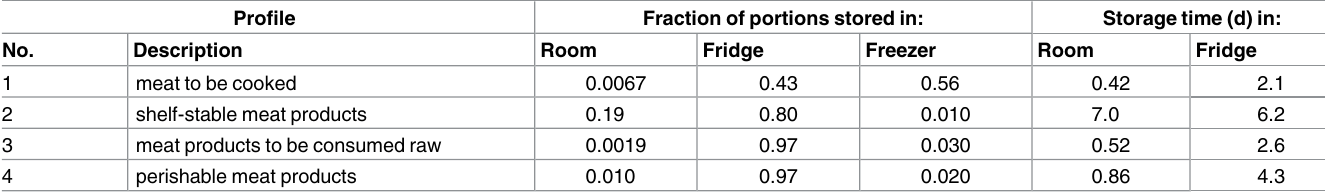
Table 4. Storage profiles for meat products at the consumers